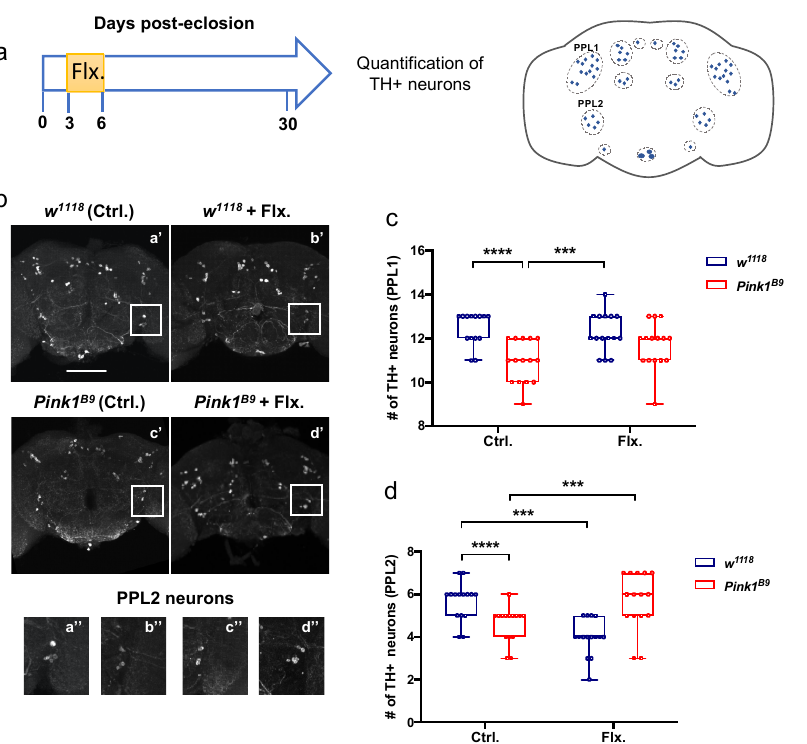
Ctrl. Flx. Figure 4. Effect of fluoxetine treatment on the survival of dopaminergic neurons in Pink1 B9 mutant and control flies. ( a ). Left panel, a scheme for the timing of fluoxetine (15 μ M) treatment. Right panel, representation of the TH-positive clusters identified in the posterior portion of the adult fly brain. ( b ) Representative images of posterior fly brain regions in 30-day-old w 1118 and Pink1 B9 flies after immunofluorescent staining with an anti-TH antibody. Flies were treated (+ Flx, b’ and d’) or not (a’ and c’) with fluoxetine. Magnification of area indicated in (a’–d’) is shown in (a’’–d’’). Scale bar: 100 μ m. ( c , d ) Quantification of PPL1 and PPL2 TH-positive neurons in each genotype and experimental condition. Data are presented as the interquartile range with maximum and minimum ranges of quantifications in 15 brains per condition. *** and **** indicate p < 0.001 and p < 0.0001, respectively; Scheirer-Ray-Hare test followed by Dunn’s post-test.